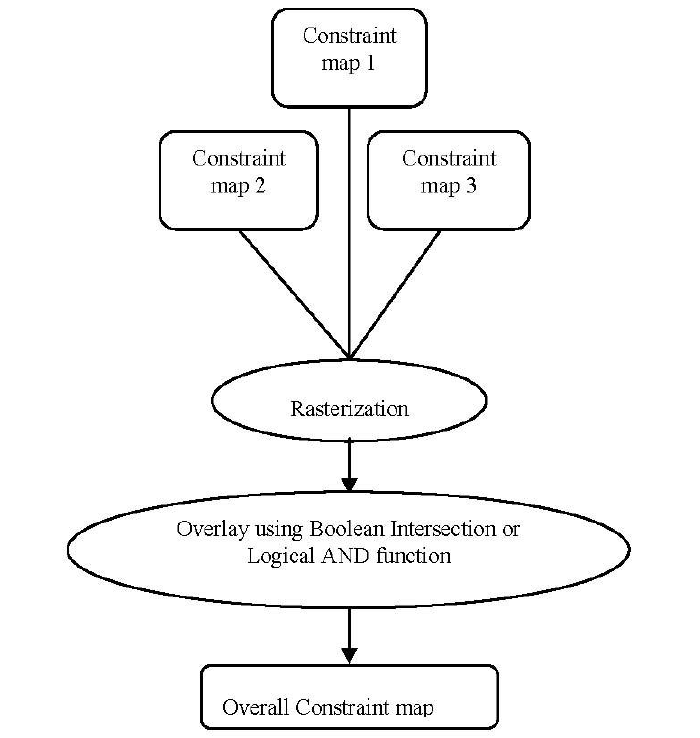
Figure 2. Steps to identify acceptable and unacceptable